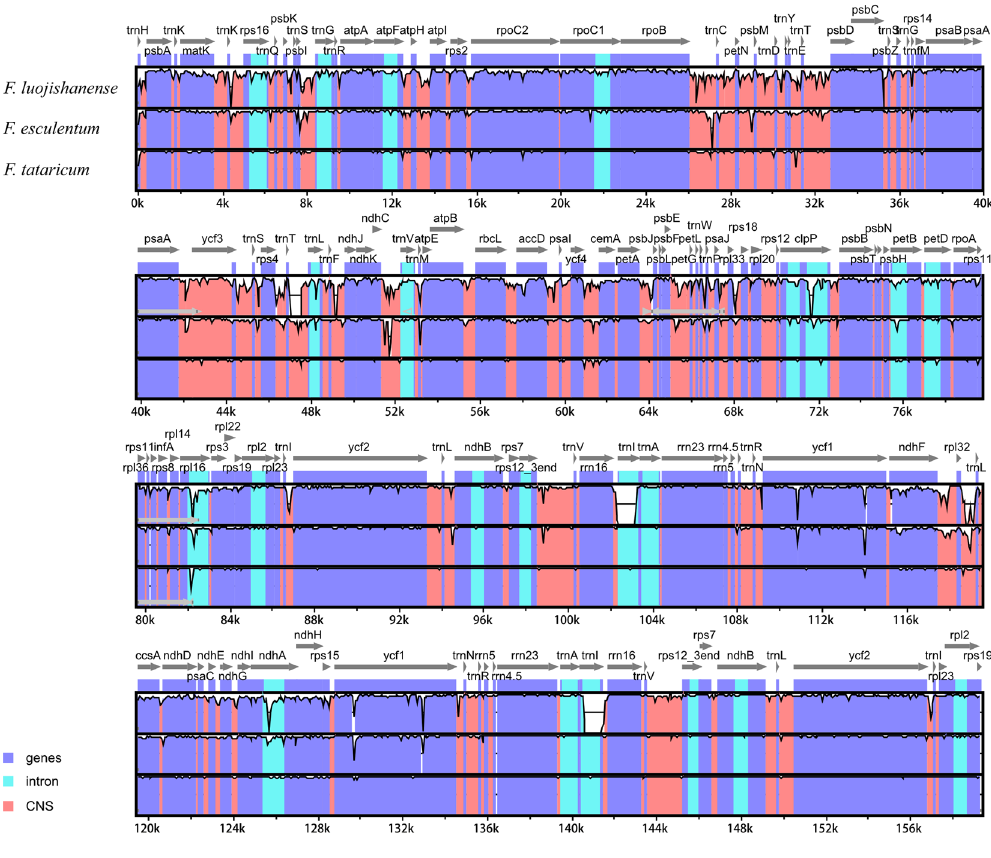
Figure 3. Sequence identity plots among the four Fagopyrum chloroplast genomes by using mVISTA. The y-axis represents identity ranging from 50% to 100%.